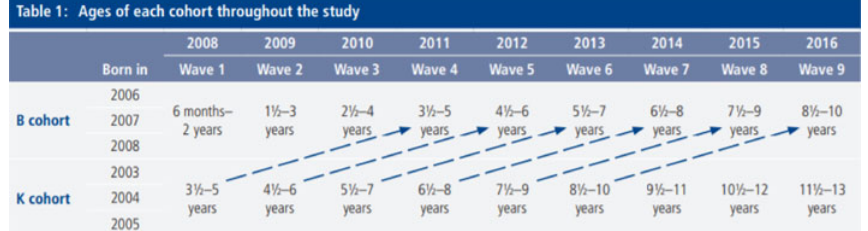
Fig. 2. Longitudinal Study of Indigenous Children Cohorts (Kneebone et al .,